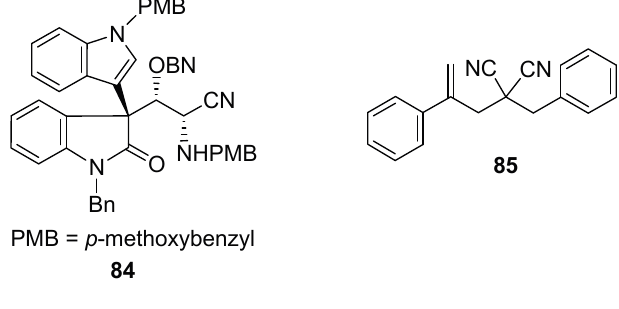
Figure 6. Structure of the nitriles 84 and 85